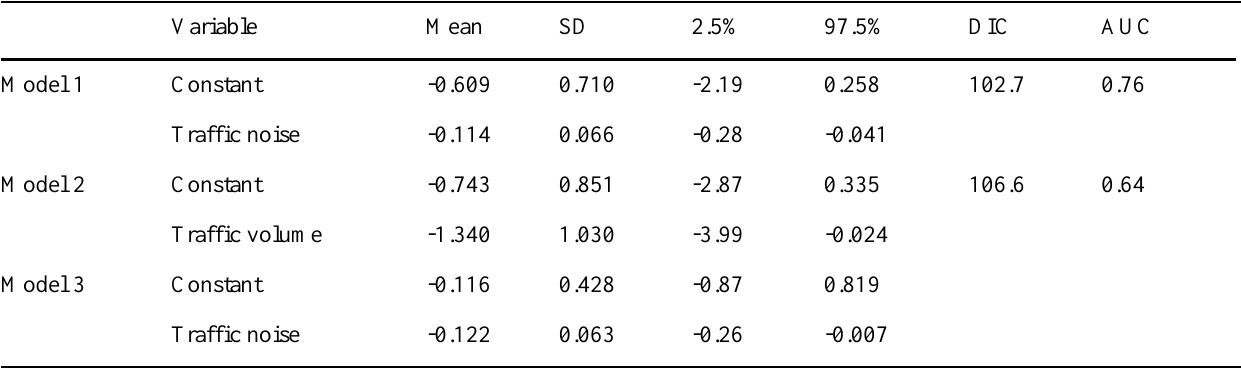
Table 2. Coefficients (Mean, SD, and 2.5th and 97.5th percentiles) of the variables included in the models of the probability of detecting the Grey Shrike-thrush on a visit to a site, as a function of traffic noise (Models 1 and 3) and traffic volume (Model 2), with the deviance information criterion (DIC) and receiver- operating characteristic curve (AUC) values for models 1 and 2. Models 1 and 2 include data from all 58 study sites, whereas Model 3 includes data from the 19 study sites in which traffic volume was < 200